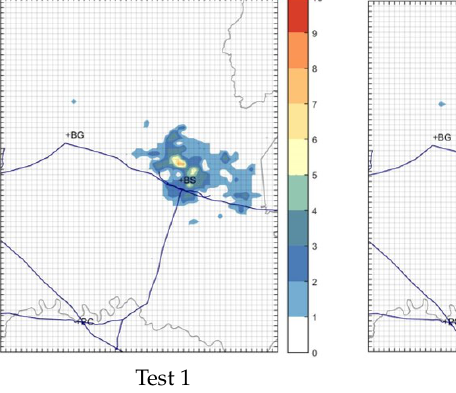
Figure 8. Map of exceeded days